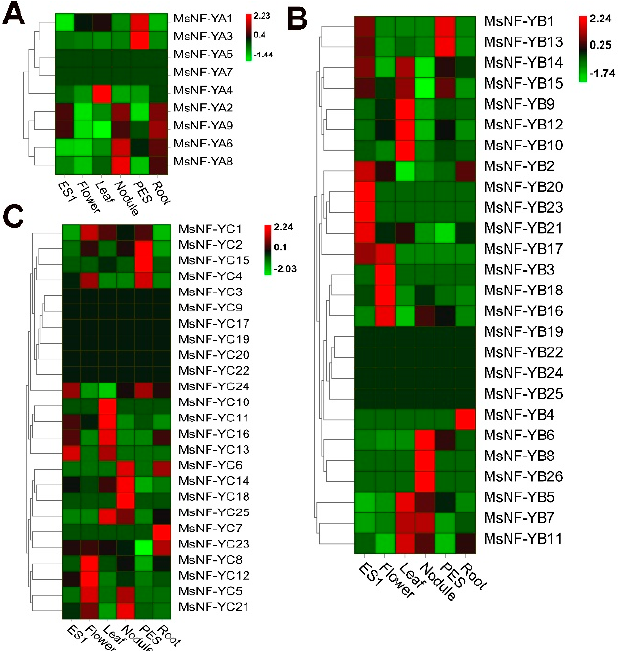
Figure 7. Expression pattern analysis of the 60 MsNF-Y genes in various alfalfa tissues (ES1, elongated stem; flower; leaf; nodule; PES, preelongated stem; and root). ( A ) MsNF-YA genes. ( B ) MsNF-YB genes. ( C ) MsNF-YC genes.